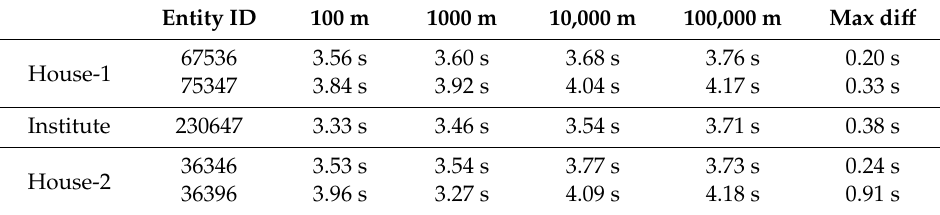
Table 9. Processing time (10 repetitions) for building components.